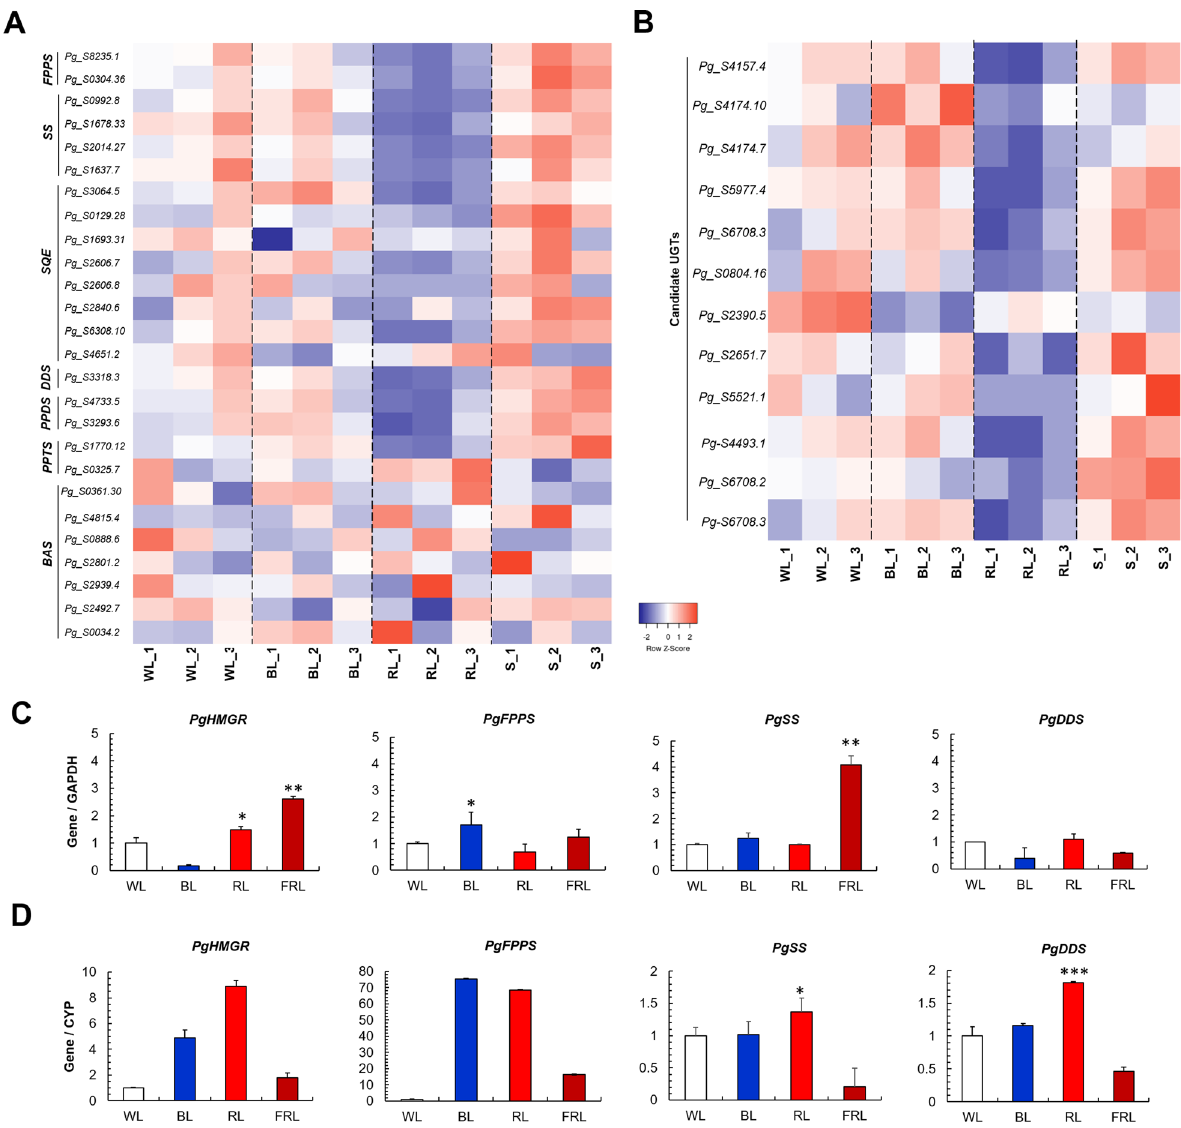
Fig. 3 Expression pattern of ginsenoside triterpenoid biosynthetic genes in ginseng leaf tissues under various light conditions. A Heat map showing the expression pattern of ginsenoside biosynthetic genes. B Expression pattern of candidate UGT genes involved in ginsenoside biosynthesis. Real‑time PCR quantification of canonical ginsenoside genes encoding 3‑hydroxyl‑3‑methylglutaryl‑CoA reductase (HMGR, Pg_S), farnesyl diphosphate synthase (FPS), squalene synthase (SS), and dammarenediol synthase (DDS) from C light‑quality treated ginseng adventitious roots (adv roots) and D 2‑year‑old plants. Values represent means SE with three biological replicates (n 5). Values marked with stars differ from ± = white light significantly according to the student’s t‑test: * p < 0.05; ** p < 0.01, *** p < 0.001. The shift from blue to red in heat map corresponds to the increasing FPKM value. WL: white light; BL: blue light; RL: red light; FRL: far‑red